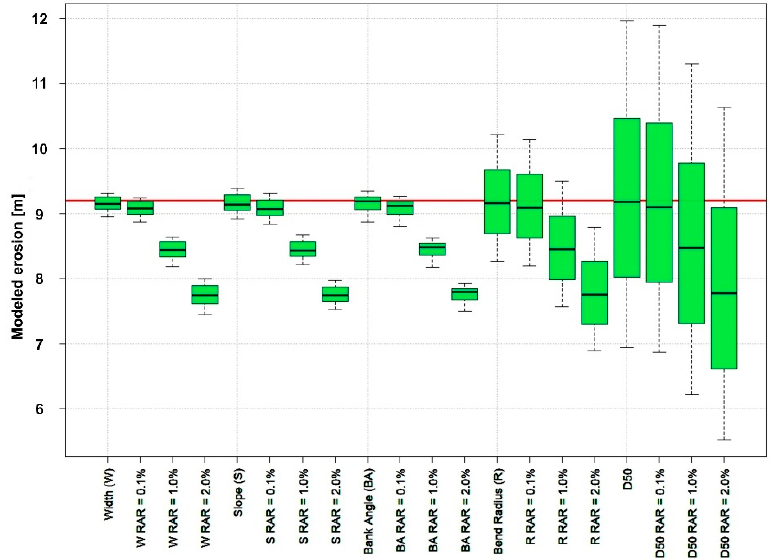
Figure 8. Sensitivity analysis representing event 12 for the Thur River catchment. For every input parameter, the value varied +/ − 10% from the original input value. The red line is the reference for the modeled erosion = 9.18 m using the original input values. Each boxplot represents the quantile of the cumulative erosion.